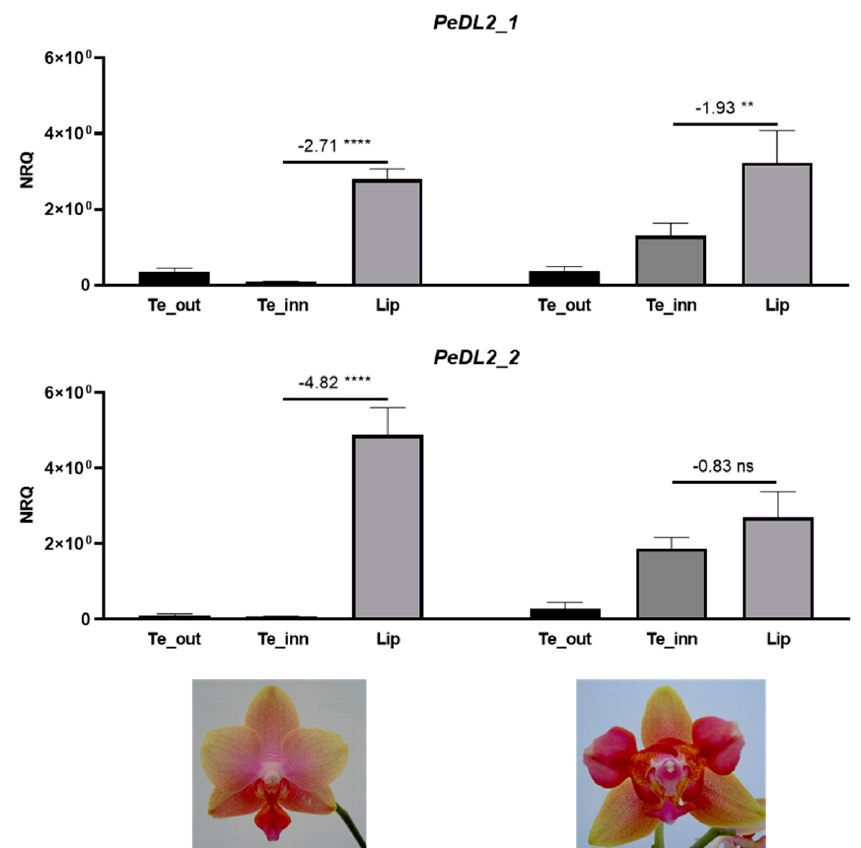
Figure 5. Relative expression of the isoforms PeDL2_1 and PeDL2_2 in the perianth of the wild- type (left) and peloric (right) Phalaenopsis hyb. “Athens” at the B2 developmental stage (bud size 1–1.5 cm). The expression is reported as normalized relative quantity (NRQ). The vertical bars represent the SEM of the biological and technical replicates. The numbers above the horizontal lines are the mean differences of the expression between lateral inner tepals and labellum (Te_inn - Lip). p -Values ** <0.01, **** <0.0001; ns, not significant. Te_out, outer tepals; Te_inn, lateral inner tepals or labellum-like structures that substitute the lateral inner tepals in the peloric mutant.